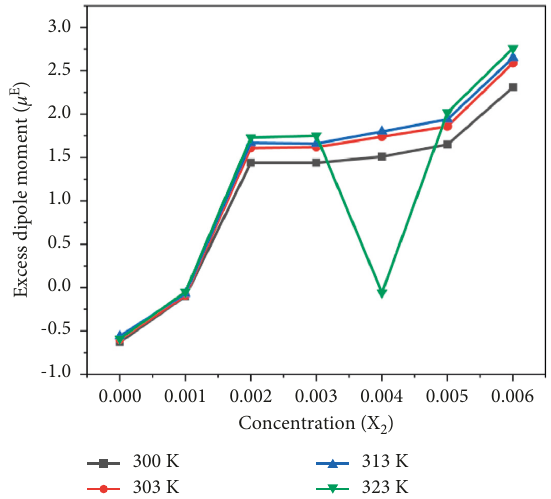
Figure 2: The variation of the excess dielectric constant values of BaO: Therm500 nanofluids.